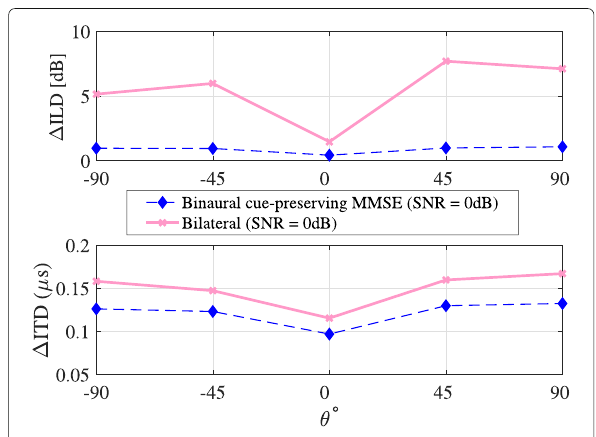
Fig. 9 Upper: (cid:13) ILD and bottom: (cid:13) ITD correspond to the binaural and bilateral gain functions, (SNR = 0 dB)